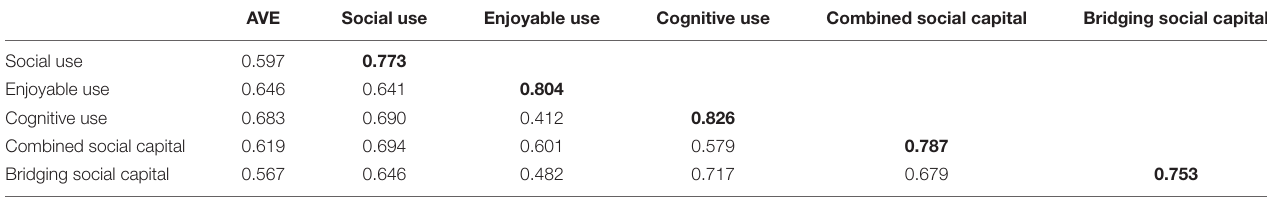
TABLE 2 | Discriminant validity of the variables.